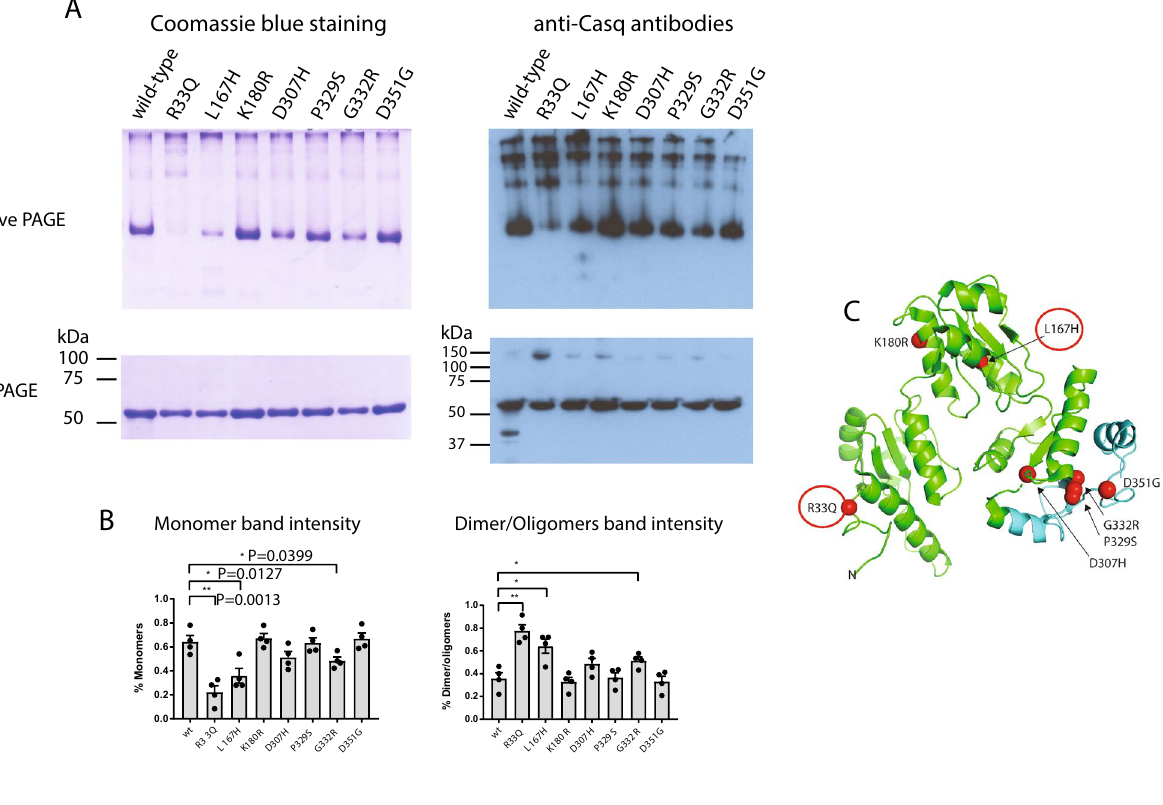
Figure 8. Polymerization of Casq2 mutants. ( A ) Polymerization of Casq2 or Casq2 mutants was carried out at 167 µM free Ca 2 followed by SDS-PAGE or native gel electrophoresis. Immunoblots were probed with anit-Casq2 antibodies. A representative of four independent experiments is shown. The full-length blots are shown in Fig. S6. ( B ) Quantitative analysis of monomeric and oligomeric forms of Casq2 mutants. ( C ) Human Casq2 crystal structure (2VAF). Red circles depict the location of Casq2 mutations with highly increased